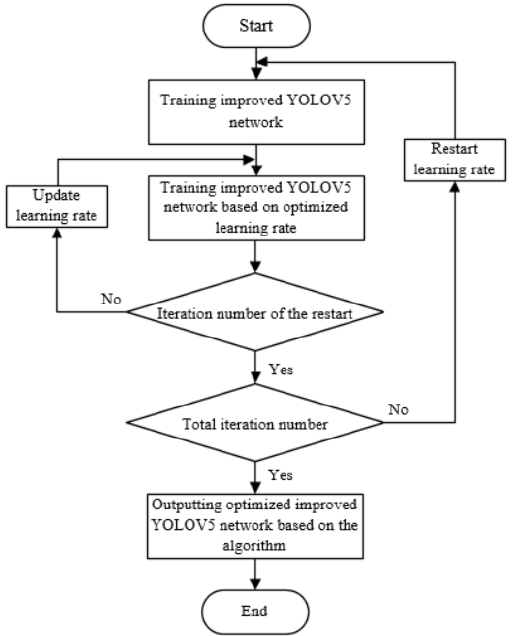
Figure 7. The optimization flowchart of YOLOV5 based on the cosine annealing with warm restarts algorithm. starts